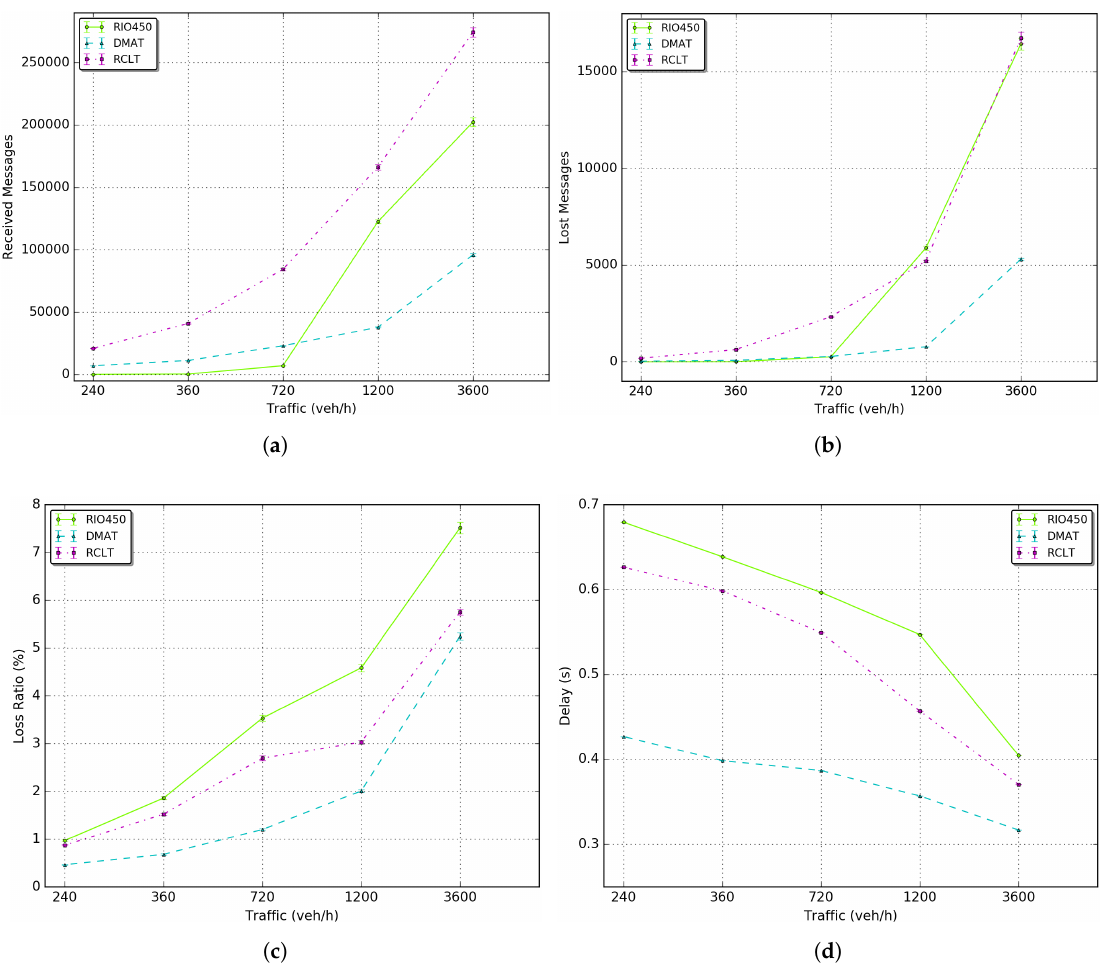
Figure 15. Network metrics: ( a ) received messages; ( b ) lost Messages; ( c ) loss ratio; ( d )